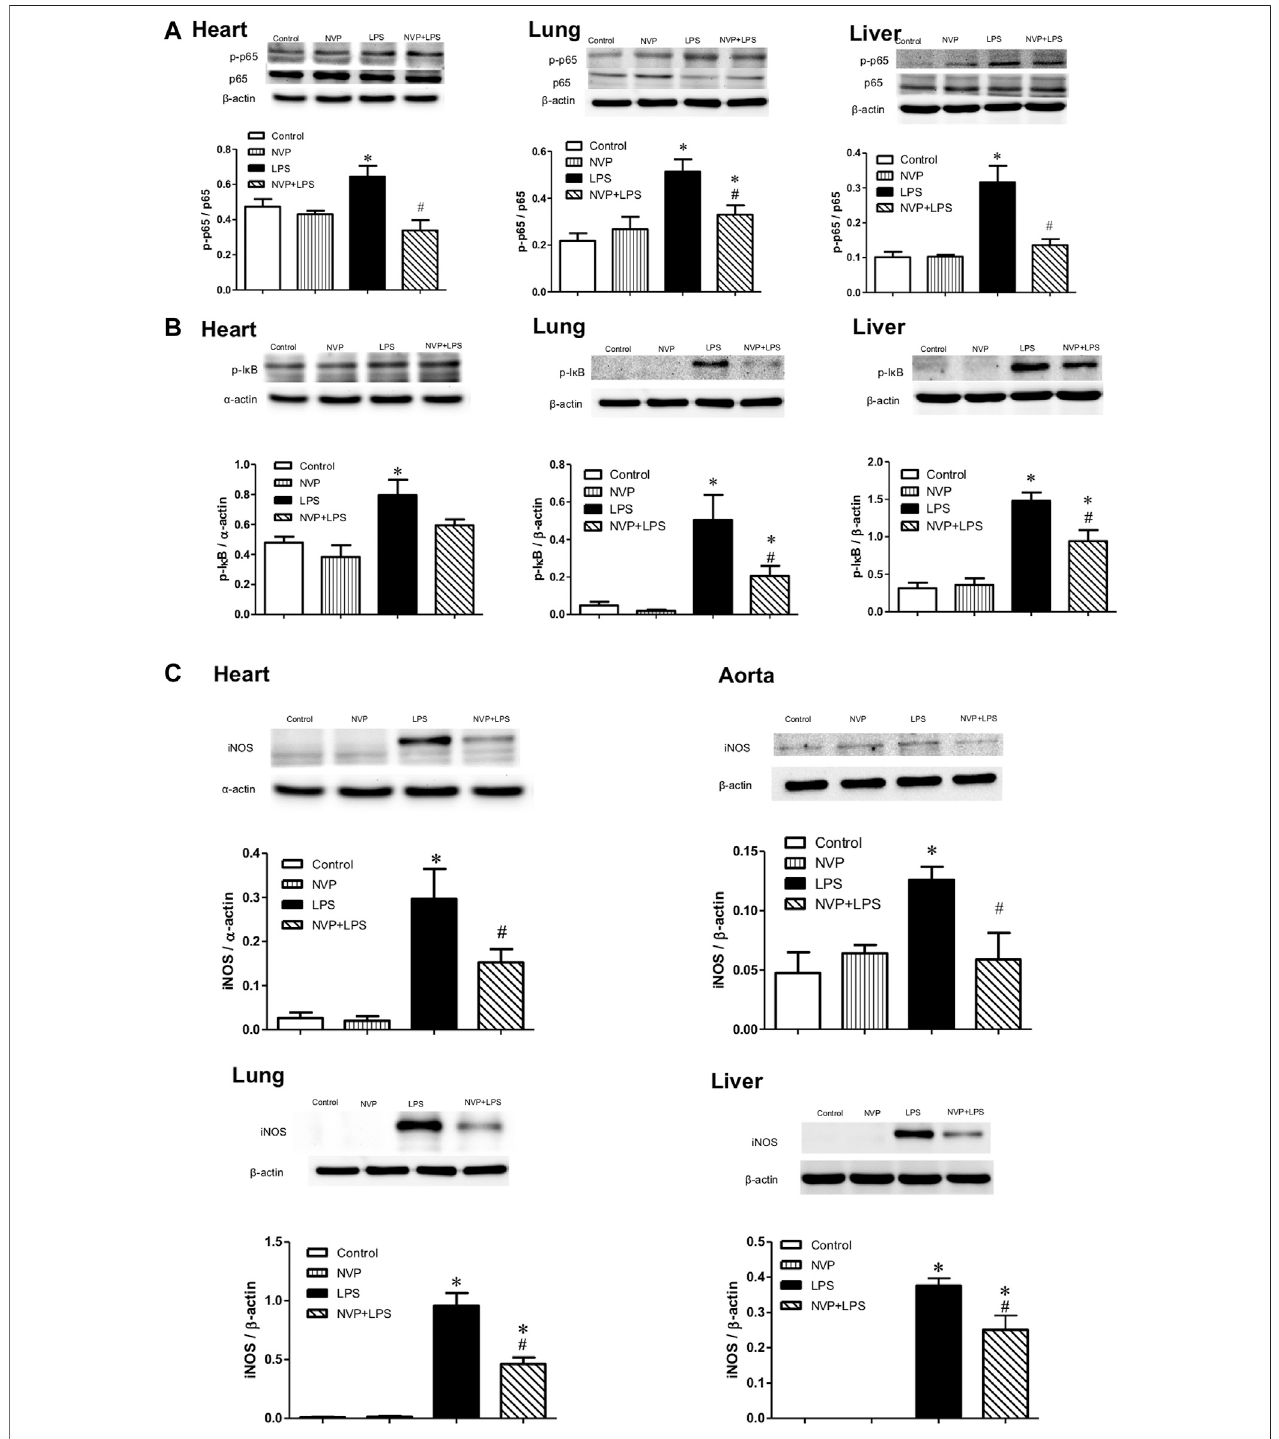
FIGURE 4 | Effects of NVP-AUY922 on proin fl ammatory proteins. (A) Phosphorylated NF- κ B p65 protein expressions in heart, lung and liver. Effects of NVP- AUY922pre-treatmentonphosphorylatedNF- κ Bp65(p-p65)inhearts,lungs,andlivers6 hafterLPSadministrationinrats. (B) PhosphorylatedI κ Bproteinexpressions in heart, lung and liver. Effects of NVP-AUY922 pre-treatment on phosphorylated I κ B ( p -I κ B) in hearts, lungs, and livers 6 h after LPS administration in rats. (C) Protein expression of iNOS in cardiovascular system, lung and liver. Effects of NVP-AUY922 pre-treatment on iNOS in hearts, aortas, lungs and livers 6 h after LPS administration in rats. NVP: NVP-AUY922 5 mg/kg. Values are expressed as mean ± SEM. * p < 0.05 vs. Control group, # p < 0.05 vs. LPS group.